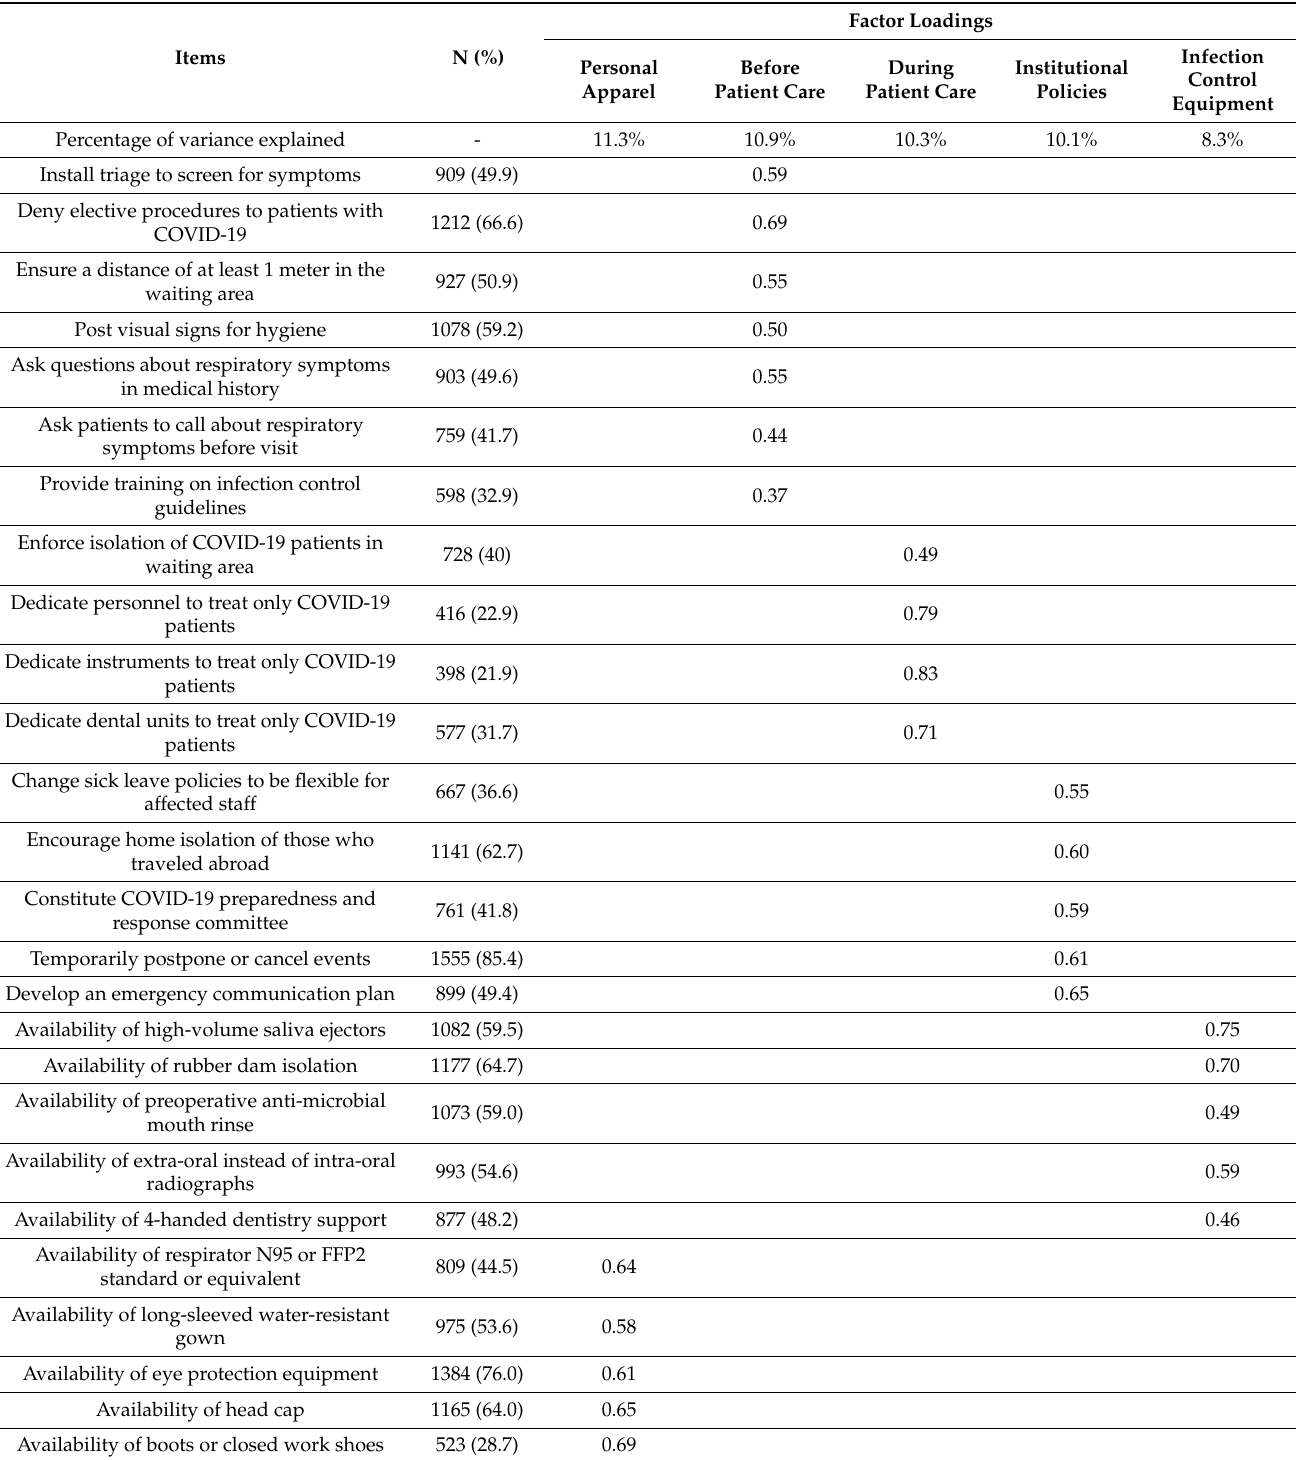
Table 2. Principal component analysis (PCA) for perceived preparedness of dental academic